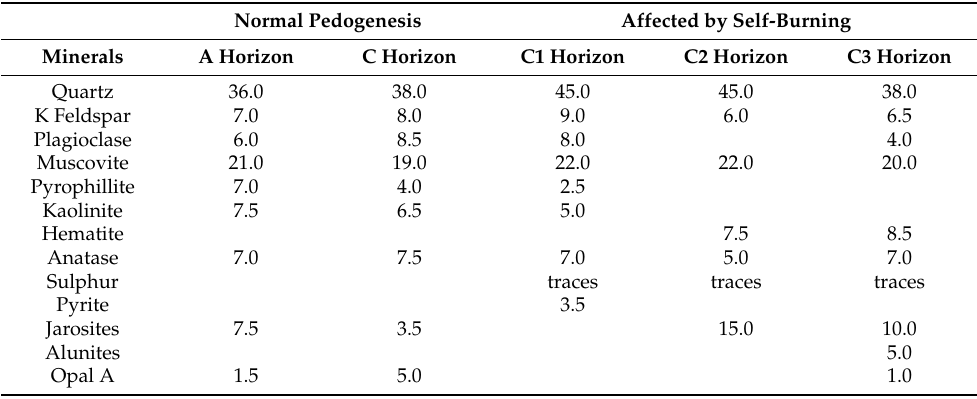
Table 4. Mineralogical composition (%) of the fine earth fraction of soil horizons from S ã o Pedro da Cova mine waste